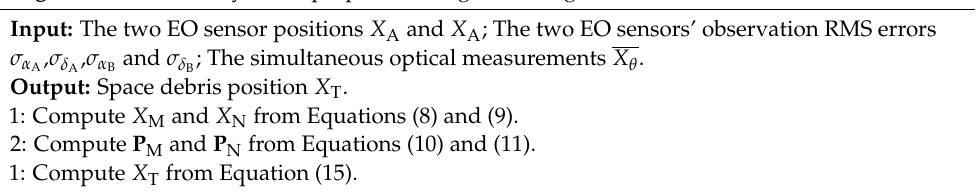
Algorithm 1. Summary of the proposed triangulation